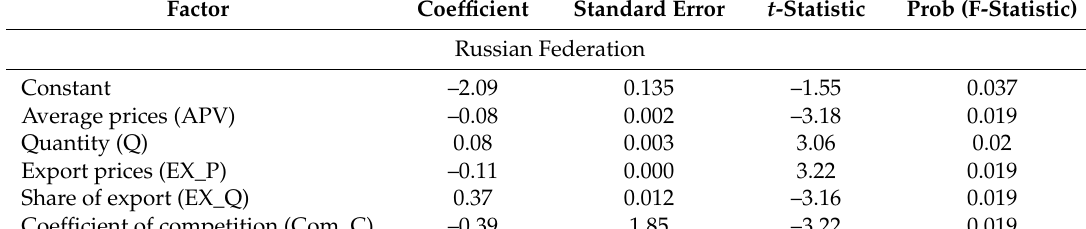
Table 7. Results of the regression analysis of competition factors of corn in Russia, Kazakhstan, and Belarus from 2010 to